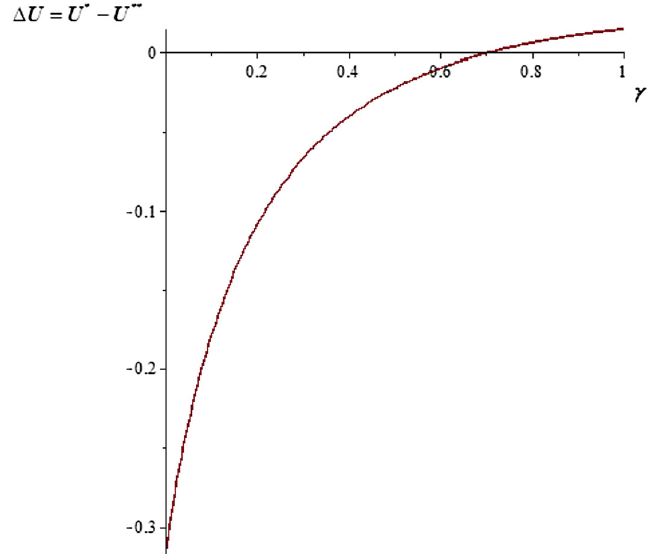
Fig. 2 Optimality of both accounting systems depending on c under full commitment. Parameters of the example: r ¼ 1 ; r ¼ 2 ; v ¼ 5 ; k ¼ 0 :